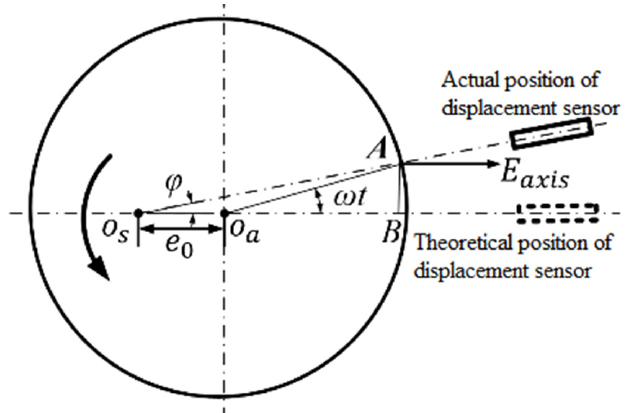
Figure 11. Effect of alignment error.